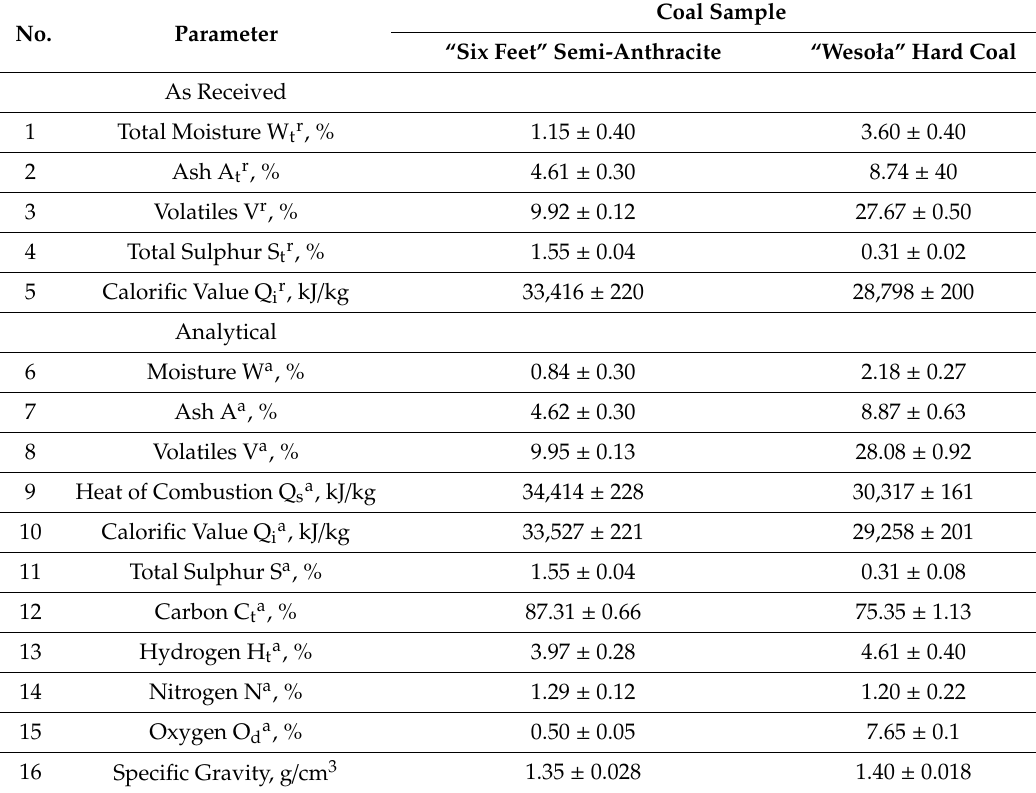
Table 1. Proximate and ultimate characteristics of coals used for the gasification